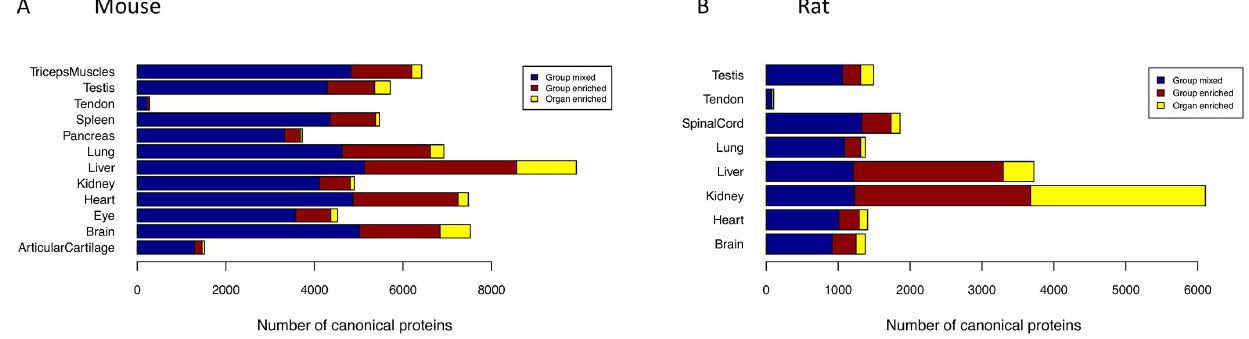
Fig 6. Organ specificity of canonical proteins in (A) mouse and (B)